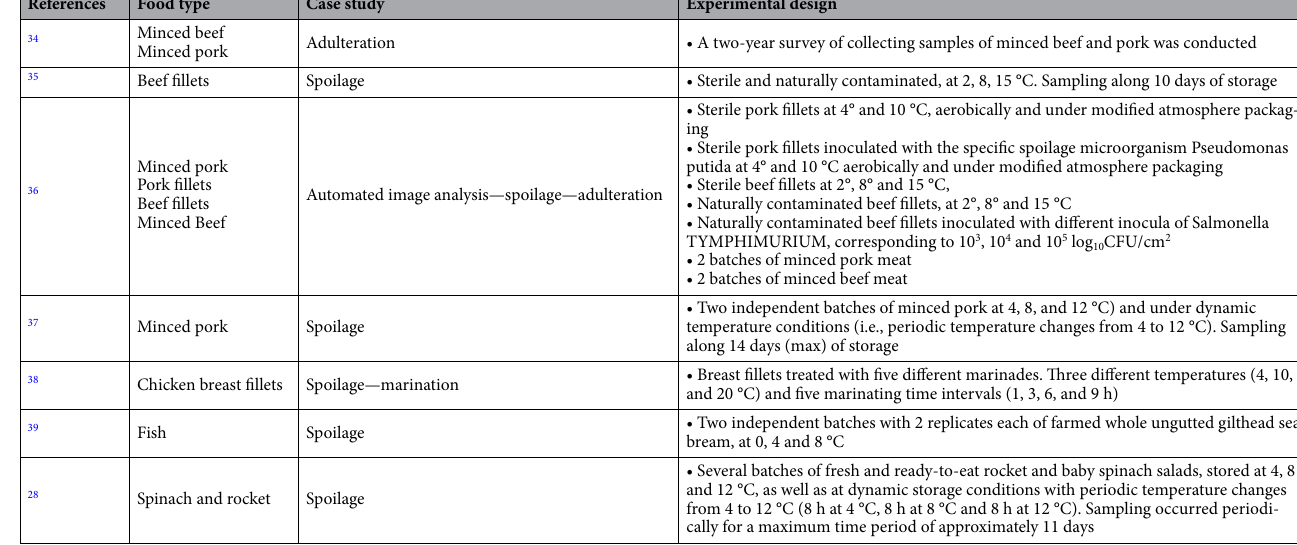
Table 2. Brief description of the used samples from the specific references.